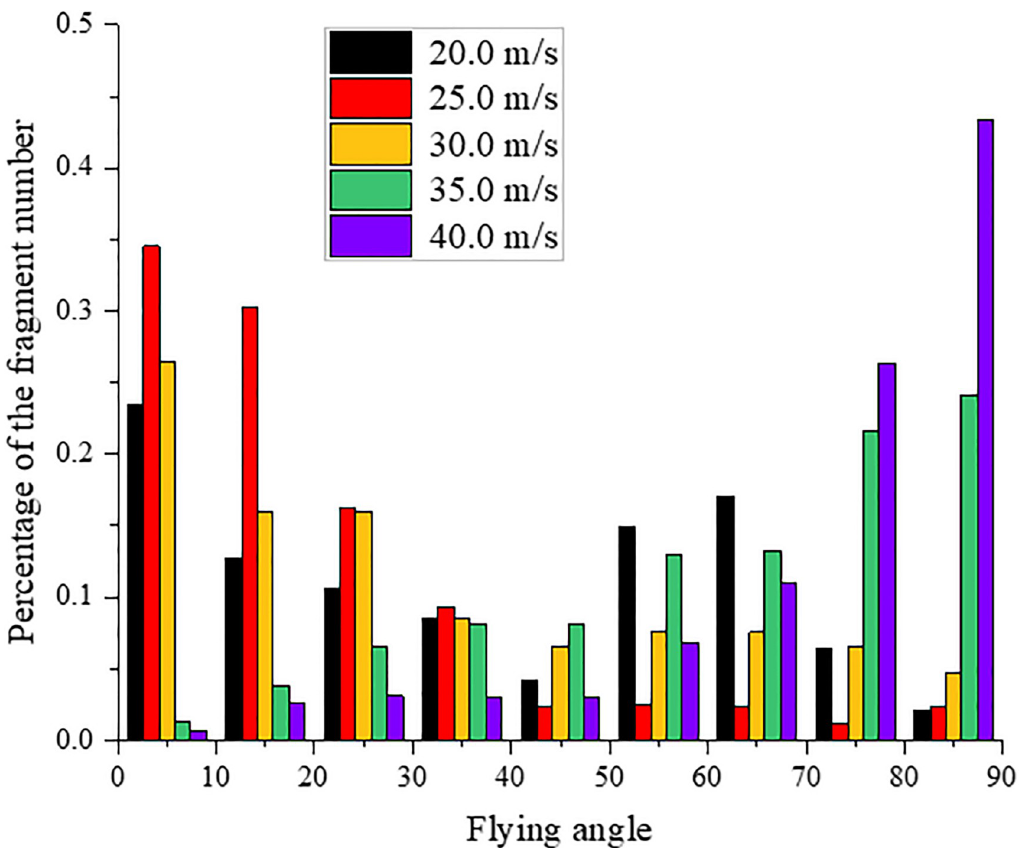
Fig 21. Distribution of the fragment flying angle at different impact